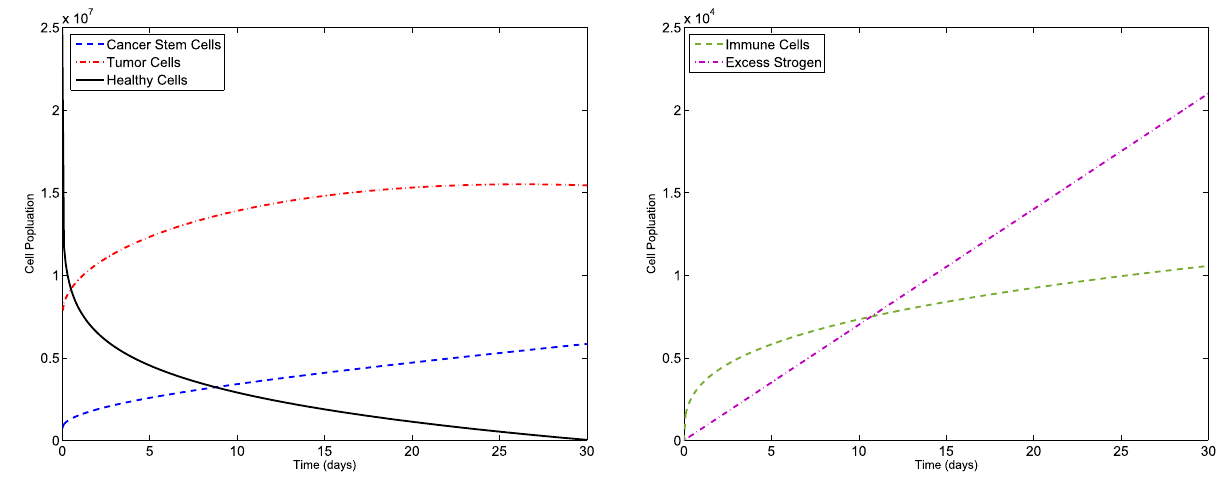
Figure 5. Evolution of { C ( t ) , T ( t ) , H ( t ) , I ( t ) , E ( t ) } vs time for the F-BCCM with m 1 = m 2 = 4 , m 3 = 5 ,